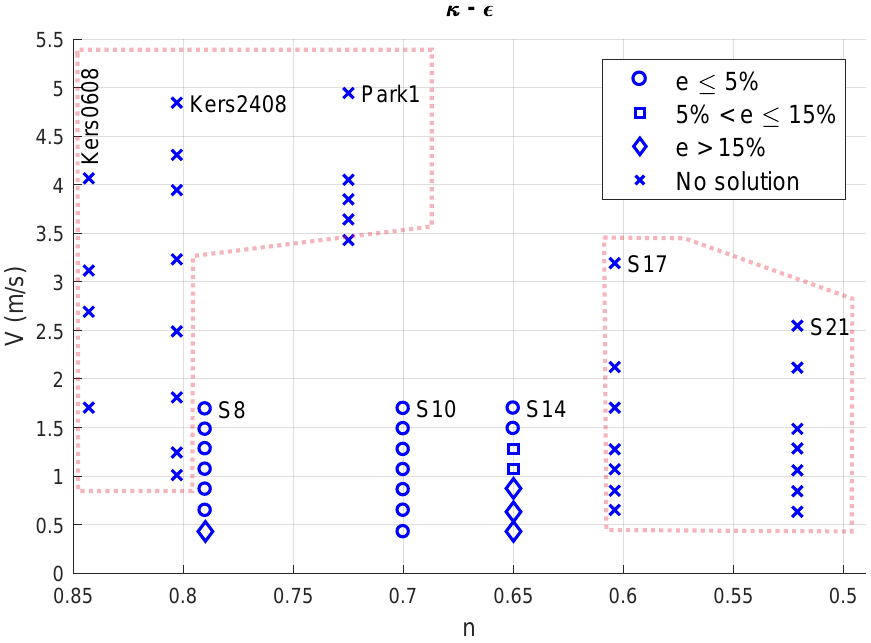
Figure 5. Error with the standard κ − (cid:101) model without ψ 1 (or ψ 2